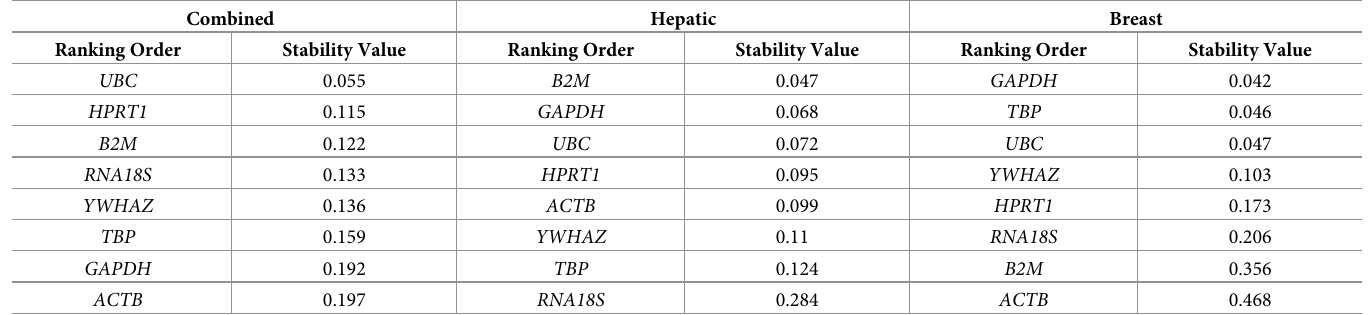
Table 4. Stability ranking order of nominee reference genes determined by NormFinder